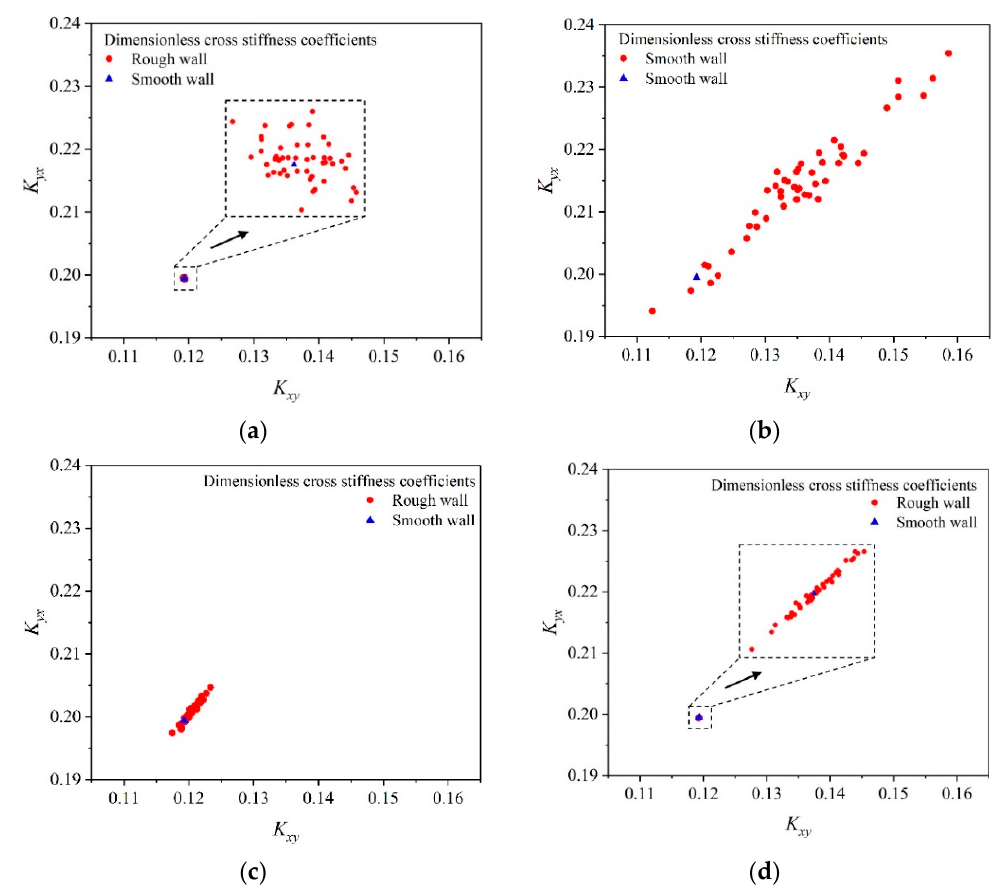
Figure 16. Cross stiffness coefficients distribution with wear in circumferential regions. ( a ) circumferential region 3. ( b ) circumferential region 4. ( c ) circumferential region 5. ( d ) circumferential region 6.